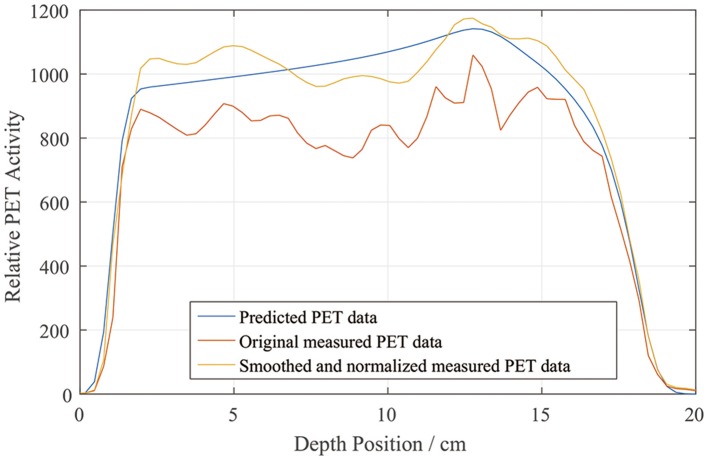
Sample depth scoring curves for predicted, measured, and smoothed and normalized PET data.